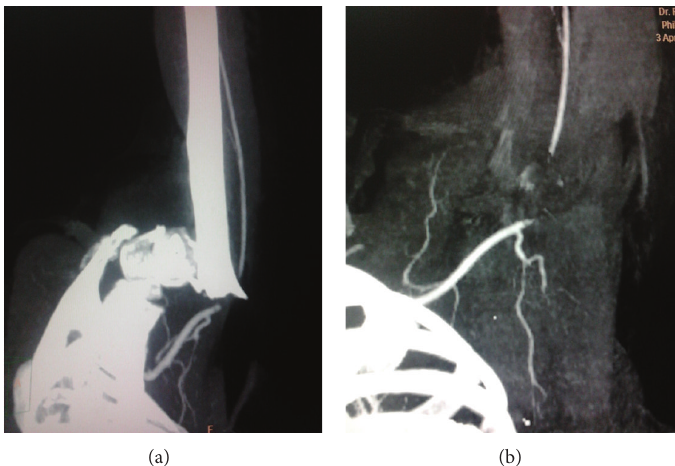
Figure 1: (a) Preoperative CT angiogram showing injury to left axillary artery by fracture proximal end of humerus. (b) Preoperative CT angiogram showing complete occlusion of left axillary artery.